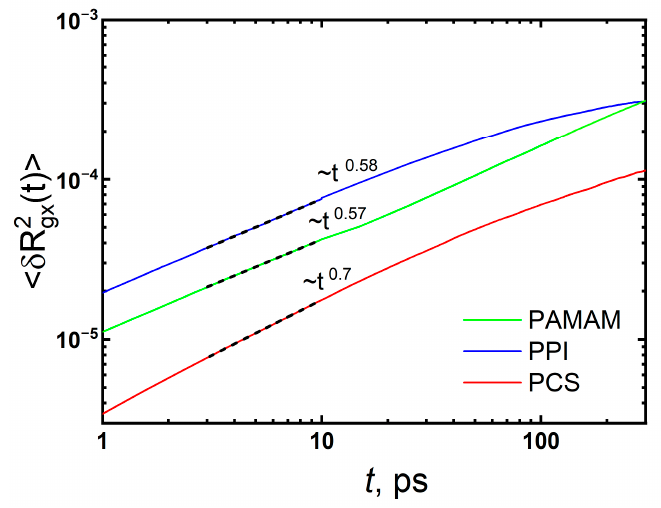
Figure 3. Fluctuations of the x-component of the gyration tensor ⟨ δ R g,x2 (t) ⟩ ≡ ⟨ [R g,x (t) − R g,x (0)] 2 ⟩ for the dendrimers. For comparison the data for PCS melt are adapted with permission from Ref. [40]. 2019, American Chemical Society.